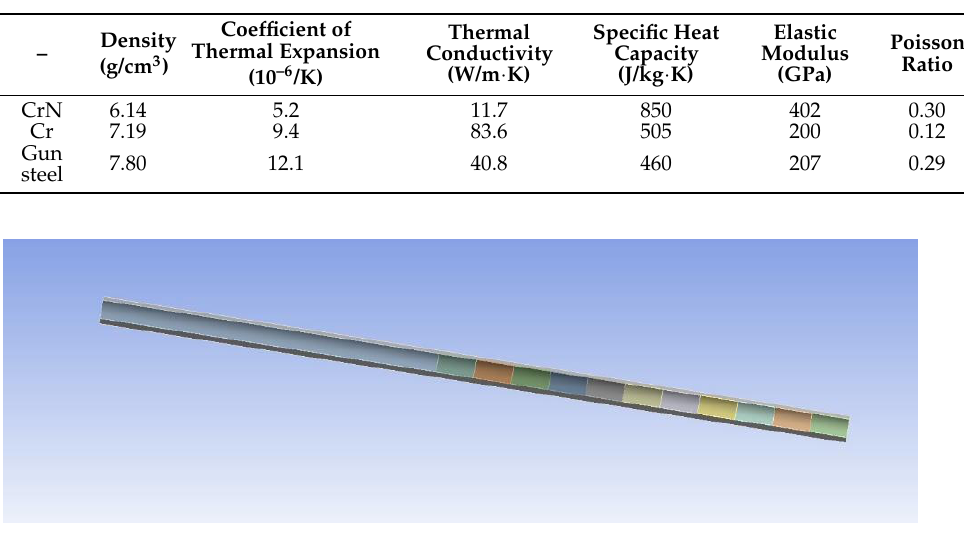
Figure 1. The finite element simulation model of the gun barrel. Figure 2 shows the number of grid divisions and cross-sectional diagrams. The number of nodes is 374,856 and the number of grids is 73,200. The overall grid quality is high.